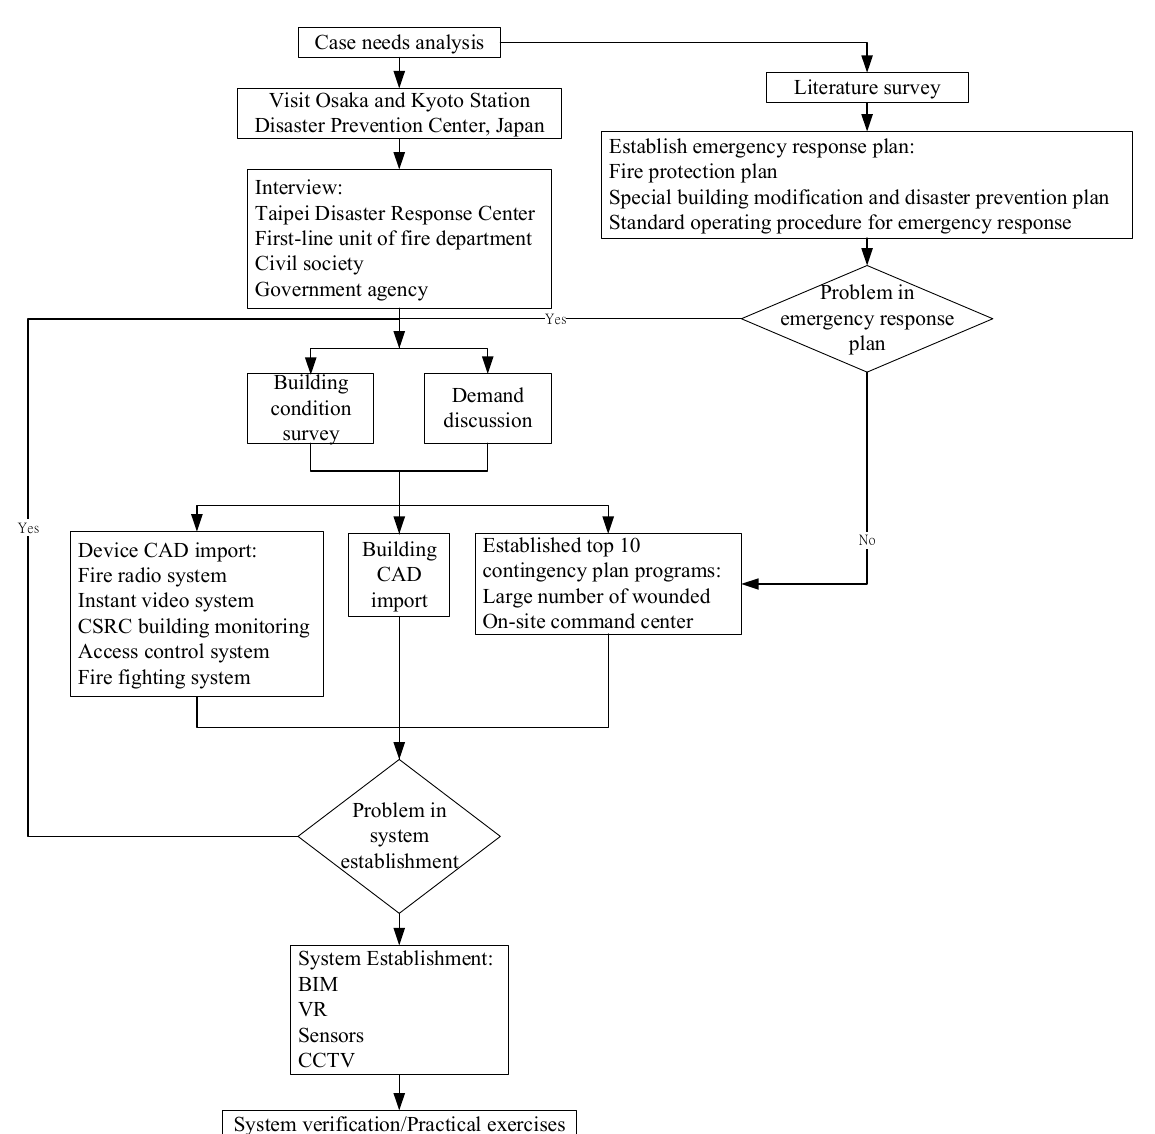
Figure 2. System research flow chart (Source: Research Data).